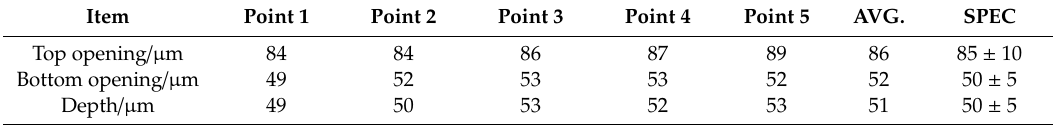
Table 6. The top opening width, bottom opening width and depth of via in the E3 process.